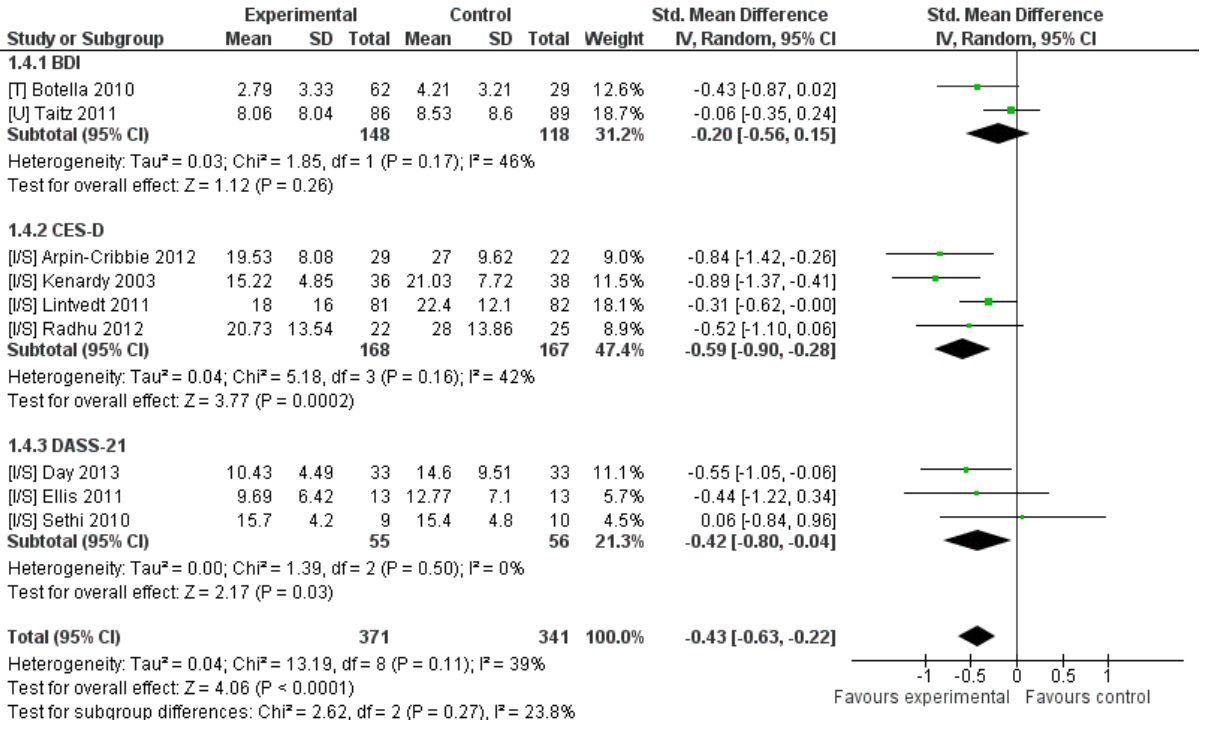
Figure 4. Sensitivity analysis of post-intervention depression outcomes for intervention compared to inactive